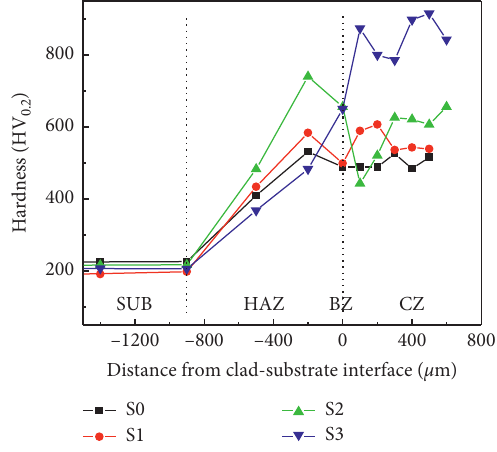
Figure 4: Cross section microhardness distribution of the laser cladding.